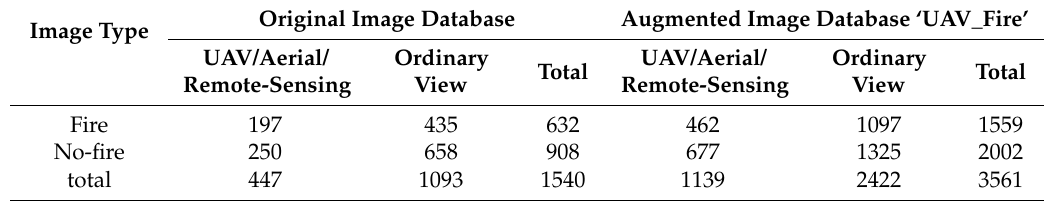
Table 4. Description of original and augmented image database